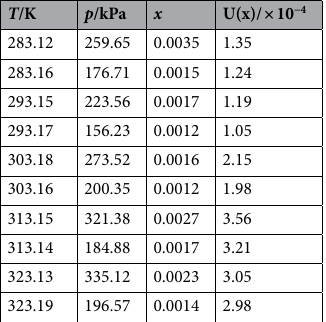
Table 2. Solubility (mole fraction) of CO 2 in